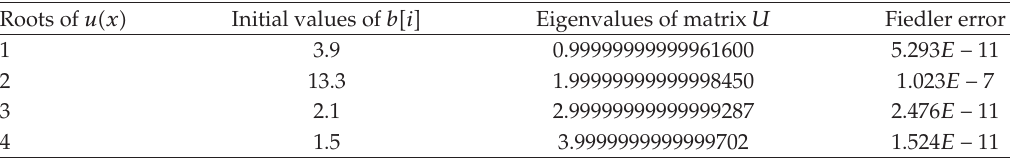
Table 4: Achieved roots of polynomial in Example 7.1 by considering initial values (cid:5) one of the approximations is away from real value (cid:6)